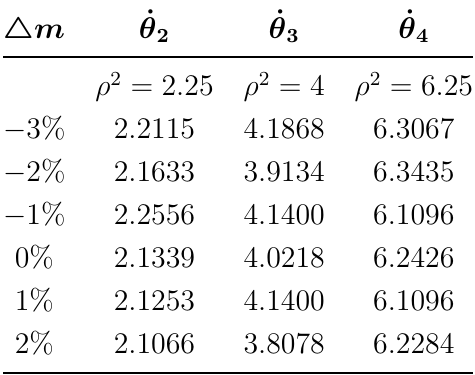
Table 2. Ratios of the Cartesian position errors of the end-effector of the PUMA 560 robot caused by ˙ θ , ˙ θ and ˙ θ to the Cartesian position errors caused by ˙ θ 2 3 4